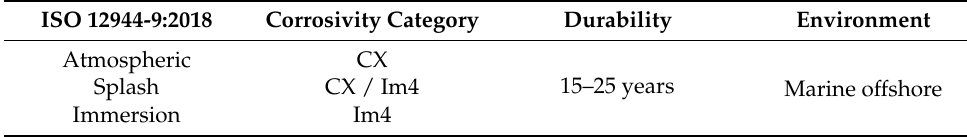
Table 1. Corrosion zones defined in ISO